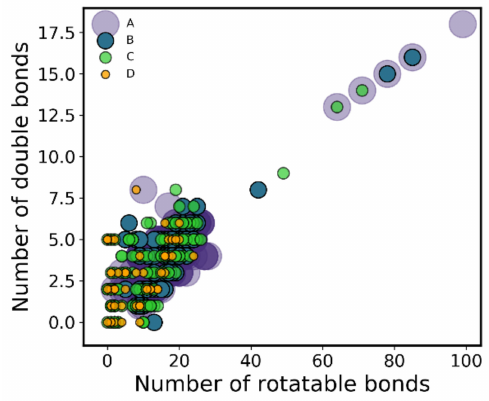
Figure 12. Distribution number of rotatable bonds (left) and number of double bonds (right) across the di ff erent activity classes.